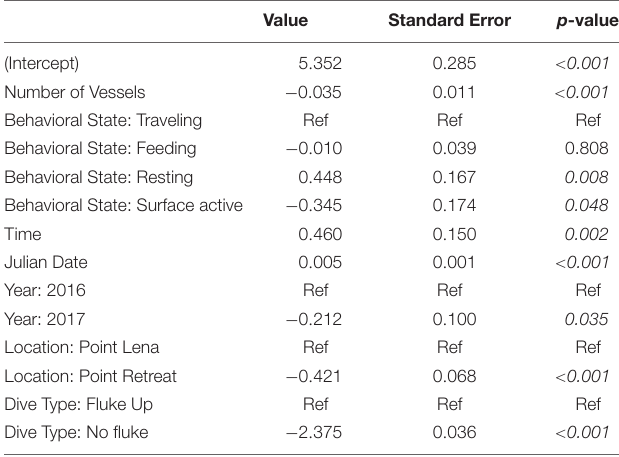
The intercept is the estimated mean log(IBI) in the absence of vessels and at the reference group (Ref), while other coefficients are differences from the Ref. Significant p-values are in Italic type. Ref, reference group in the analysis.